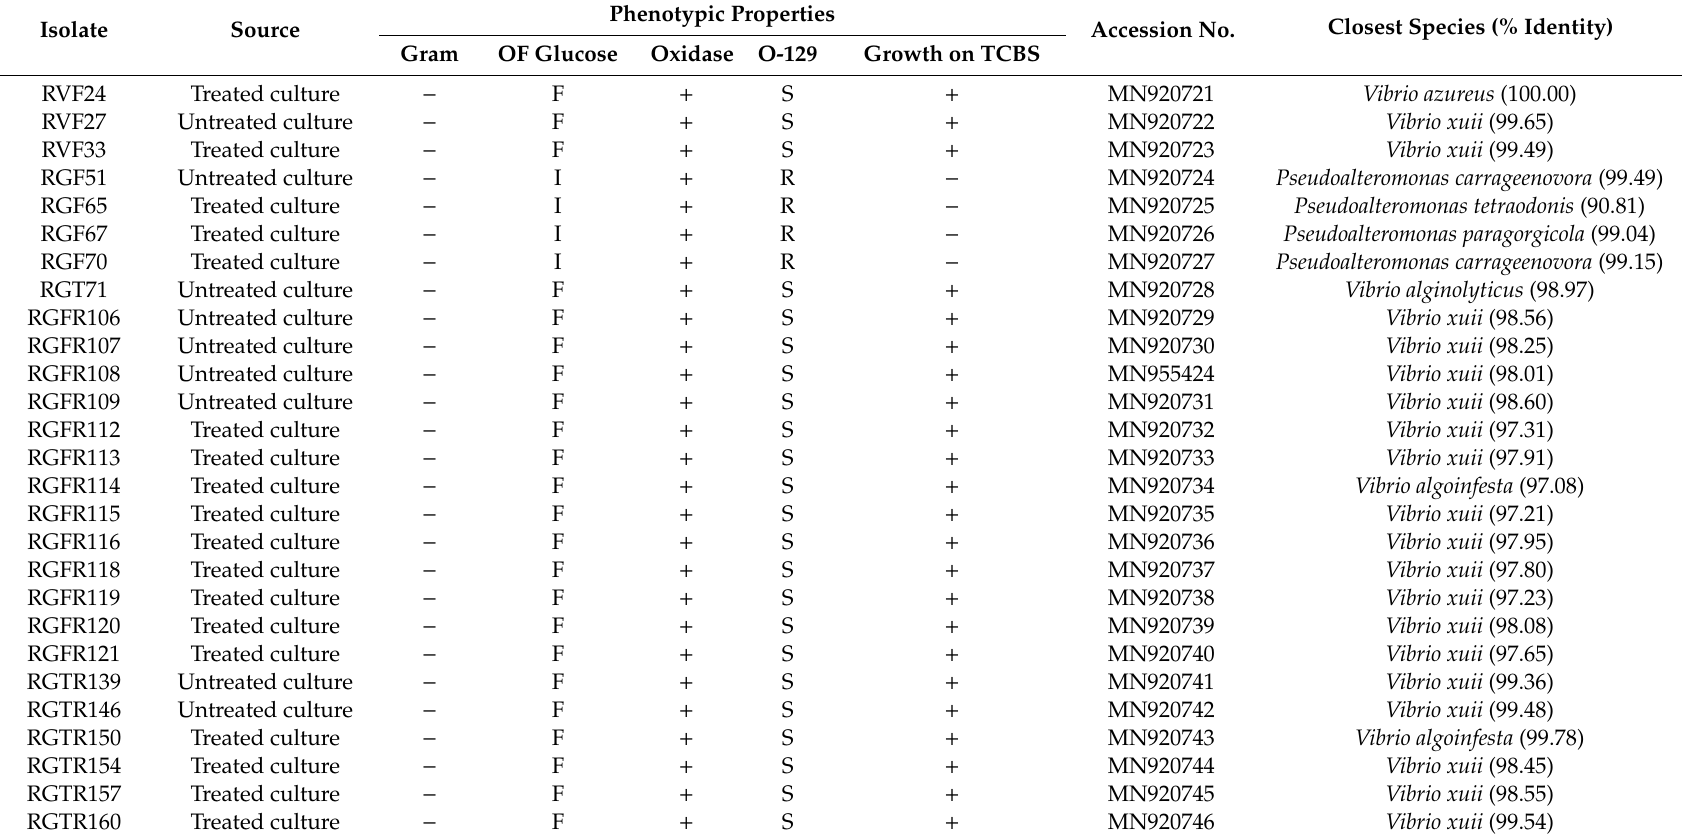
Table 2. Identification, source, and phenotypic properties of florfenicol-resistant isolates recovered from rotifer